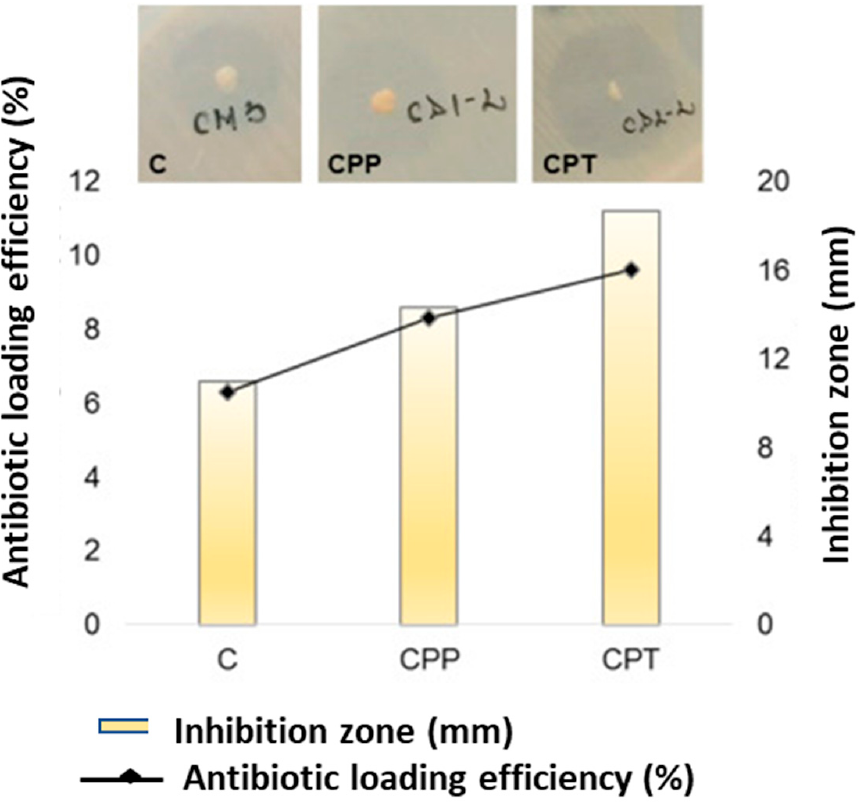
Figure 4. Antibiotic loading efficiency and antibacterial activity of the beads. Reproduced from the article [53], with permission from Elsevier, 2022. C: chitosan; CPP: chitosan/pullulan periodate; CPT: chitosan/pullulan TEMPO.